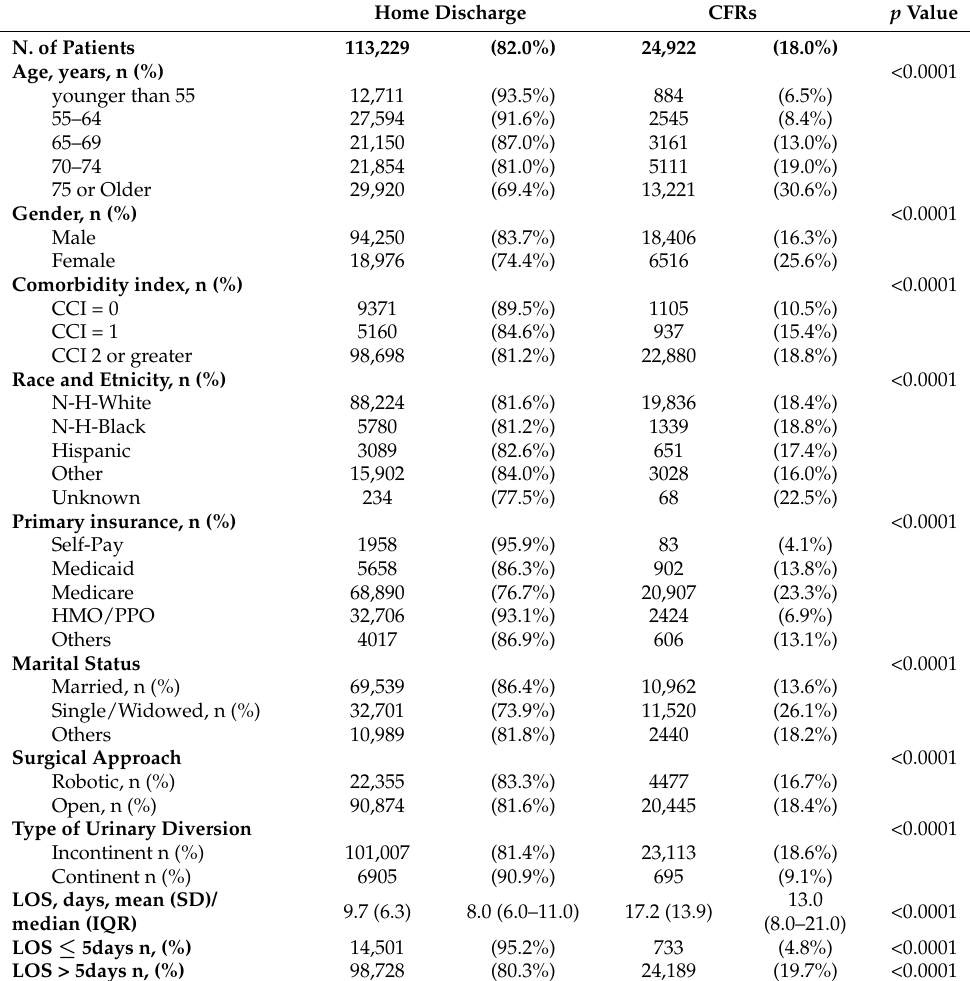
Table 1. Patients and Surgical